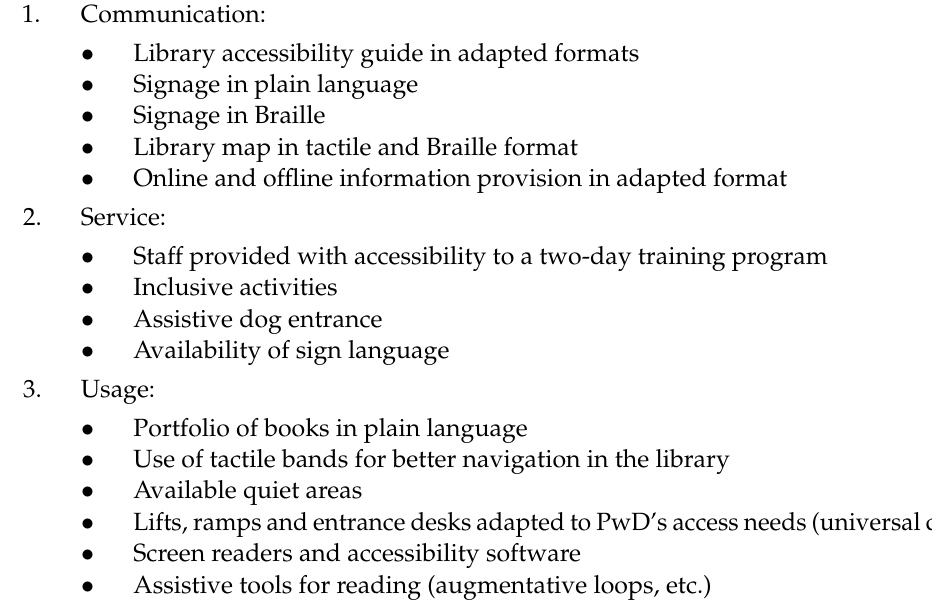
Some libraries lack physical accessibility features. ( C ) There is a lack of tactile bands in libraries. ( D ) Signposting needs to be adapted to the communication needs of users (plain language, Braille, etc.).